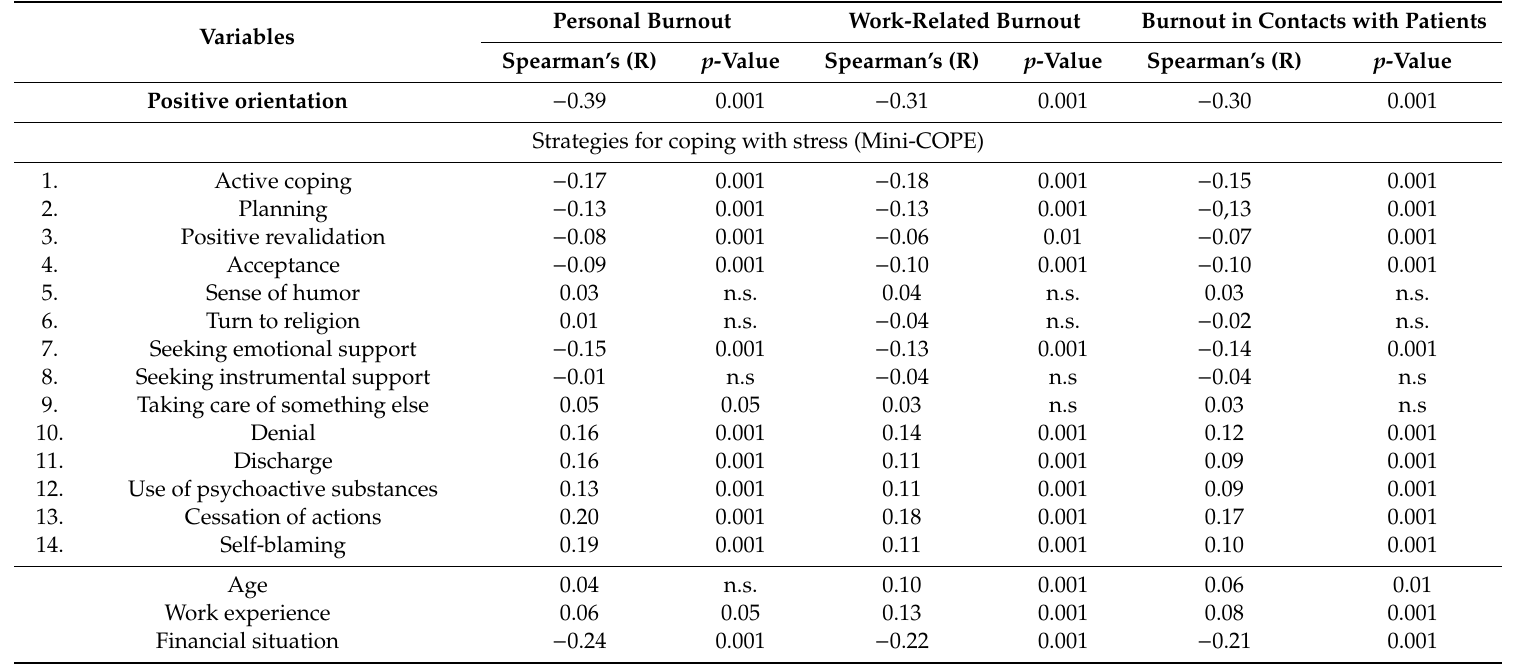
Table 3. Spearman’s (R) correlation coe ffi cients between positive orientation, coping strategies, age, work experience, and burnout